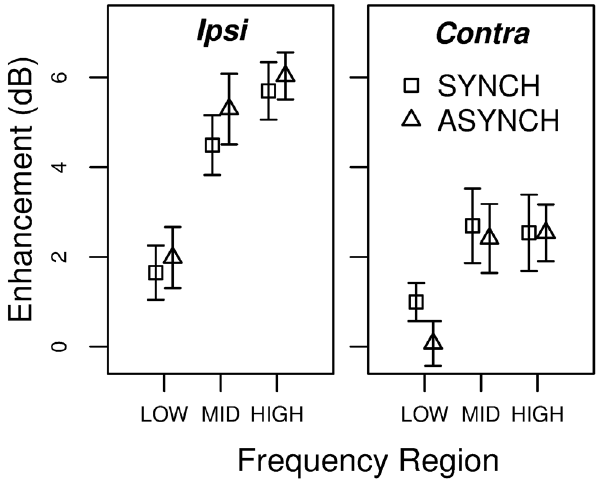
Figure 3. Average enhancement magnitude in experiment 1 ( 6 1 s.e.). The figure displays enhancement magnitude as a function of precursor laterality ( Ipsi vs. Contra ) and frequency region.